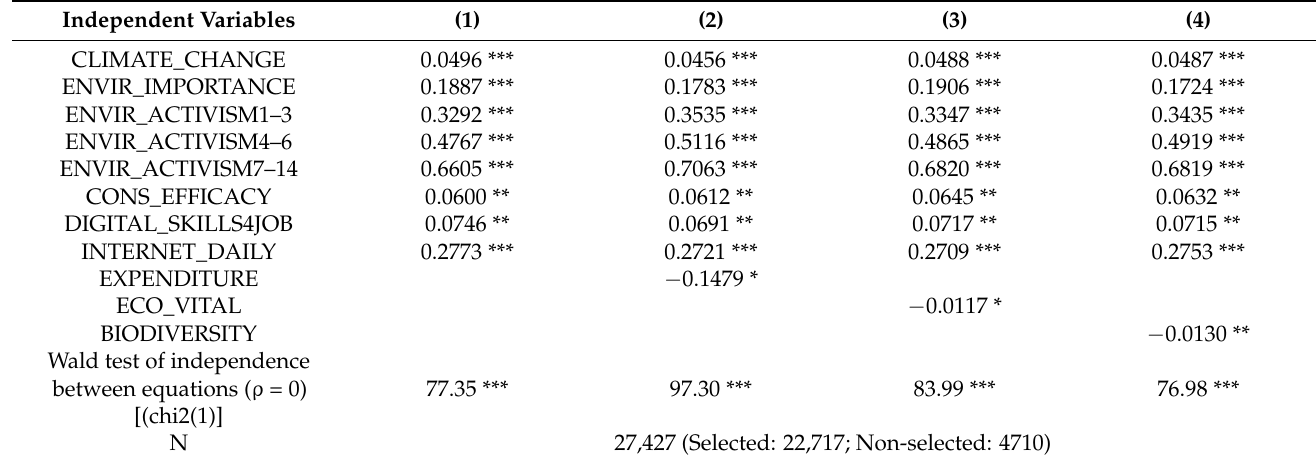
Table 4. Weighted coefficient estimates for outcome equation (dependent variable: